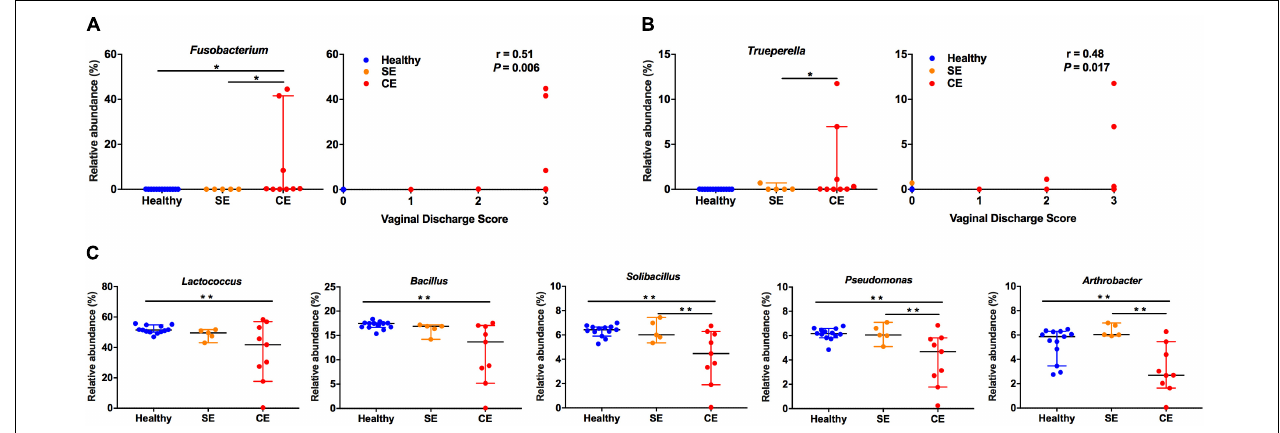
FIGURE 4 | The relative abundance distribution of Fusobacterium (A) , Trueperella (B) among groups, and correlations between vaginal discharge scores. Cows were assigned to four groups according to vaginal discharge score: 0, clear or translucent mucus; 1, clear discharge with flecks of pus; 2, mucopurulent, not fetid discharge; 3, purulent or fetid discharge. r , Spearman’s coefficient. (C) Analysis of the relative abundance of Lactococcus, Bacillus , Solibacillus , Pseudomonas, and Arthrobacter in healthy, SE and CE cows by Kruskal–Wallis rank-sum test. Symbols represent data from individual cows, data shown as median with 95% CI. Healthy, healthy cows, n = 13; SE, subclinical endometritic cows, n = 5; CE, clinical endometritic cows, n = 9. ∗ P < 0.05, ∗∗ P < 0.01.